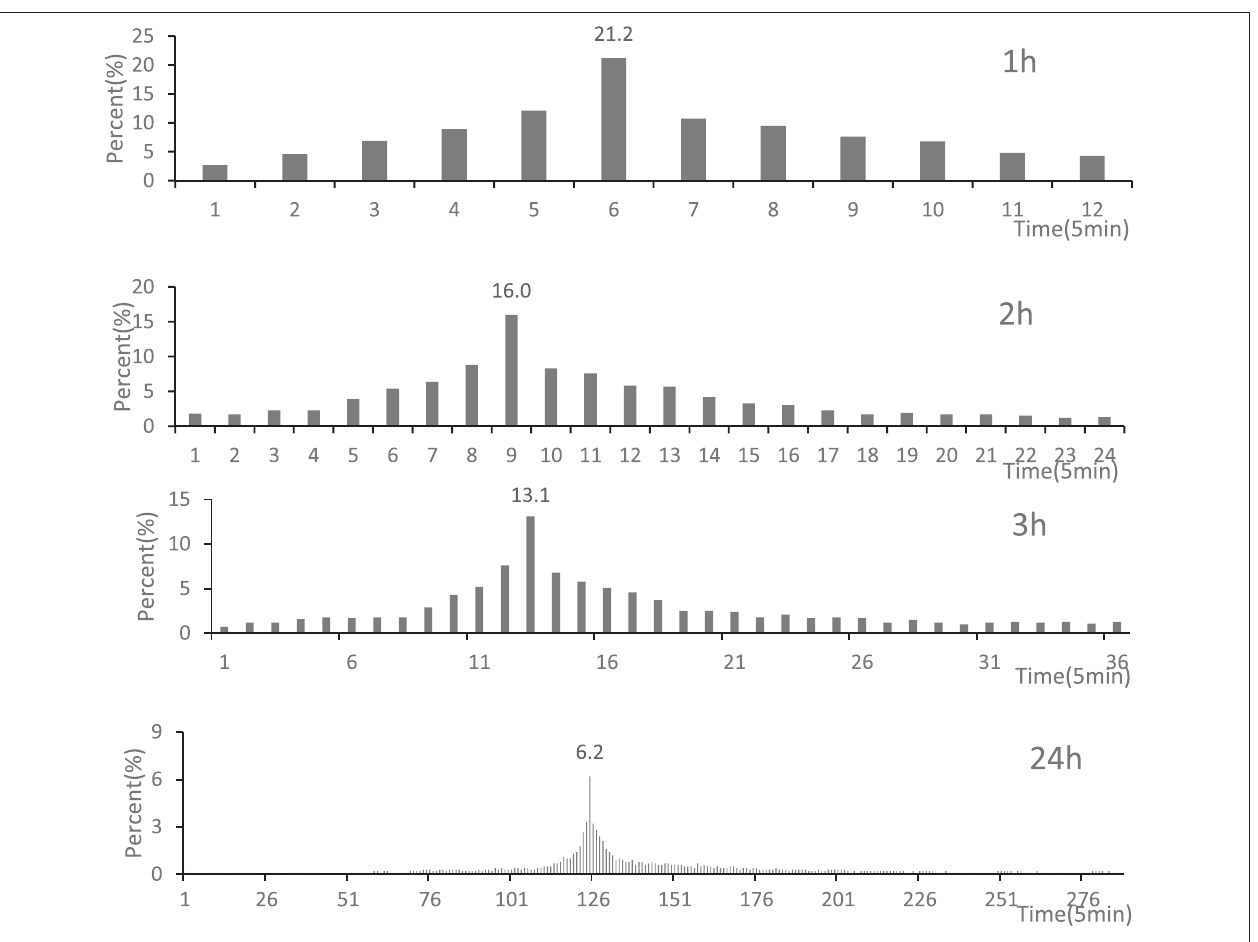
Frontiers in Environmental Science |